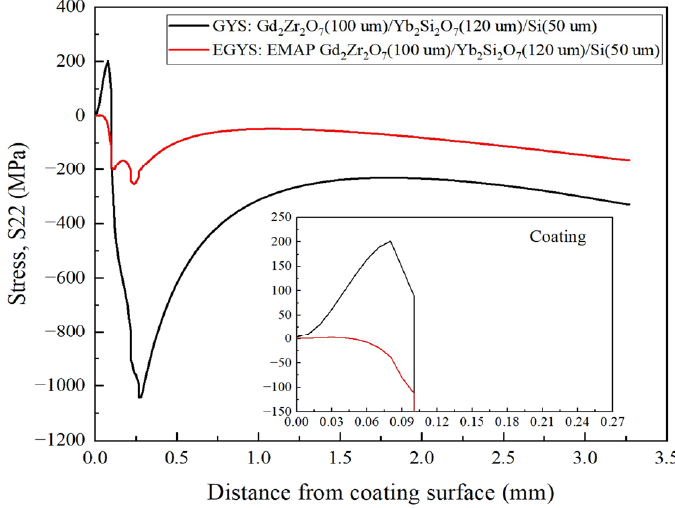
Figure 7. S22 distributions along right boundary path.